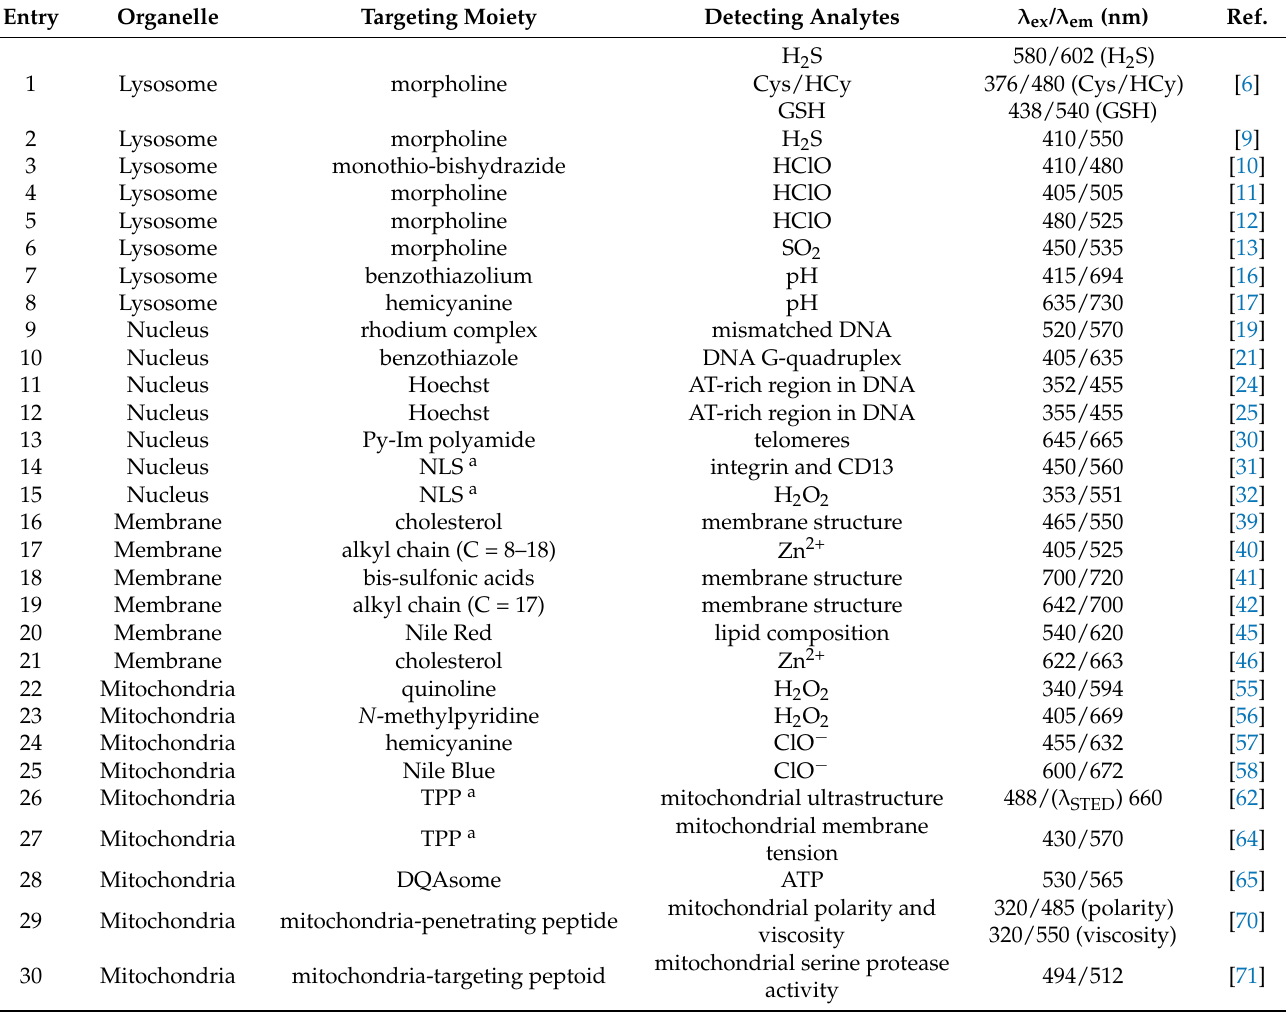
Table 1. Summary of organelle-targeted fluorescent